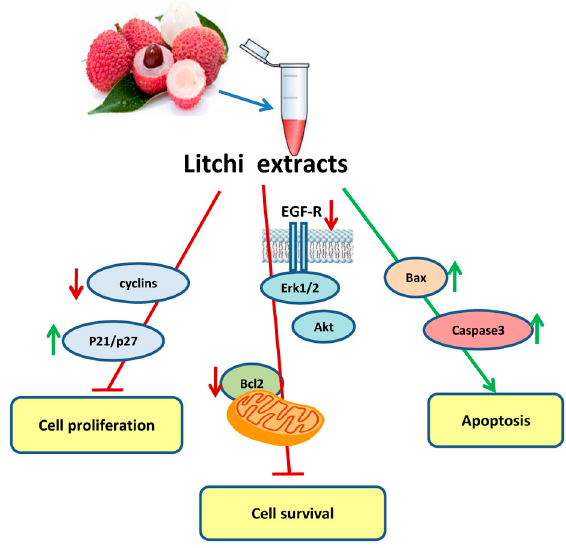
Figure 3. Scheme of the effects of Litchi extracts on cell proliferation, cell survival, and apoptosis. Red arrows indicate downregulated factors or processes, and green arrows indicate increased factors or processes. Table 2. Specific antitumor effects of Litchi fruit portions and principal involved biochemical pathways.